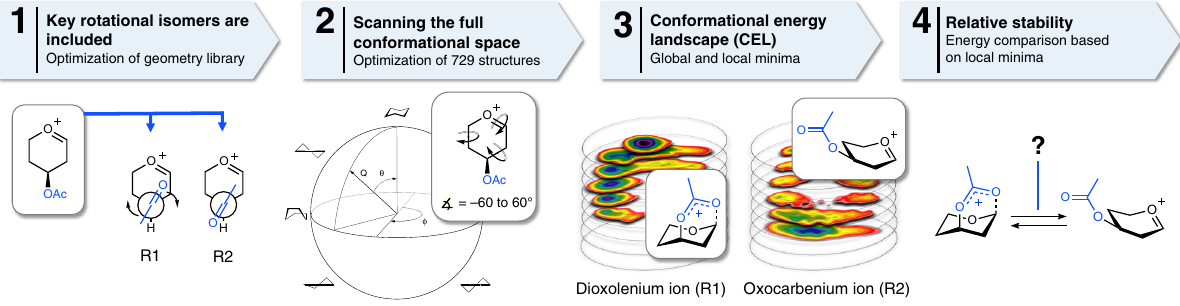
Fig. 4 Overview of the work fl ow to map the relative stability of glycosyl dioxolenium- and oxocarbenium ions. (1) Two rotamers are used to probe long- range participation: R1 makes it geometrically feasible to form dioxolenium ions, where R2 generates the free oxocarbenium ion. (2) The complete conformational space of the 6-membered rings was scanned by computing 729 pre fi xed structures per rotamer; A few canonical conformations (chair, half-chair, envelope, and boat) are depicted. (3) The associated energies were graphed on slices dividing the Cremer – Pople sphere; the CEL map of the R1 rotamer and CEL map of the R2 rotamer. (4) Based on the CEL maps of R1 and R2 the relative stability of both intermediates can